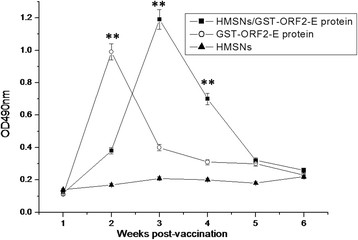
PCV2 specific serum antibody responses. Mice were immunized with the HMSN/protein complex, the protein only, or the HMSNs only;serum samples were collected every 2 weeks. Specific antibody responses in serum samples of 0, 14 and 28 d were detected by ELISA as described in Section 2. Each bar represents average values of three mice, measured in duplicate.